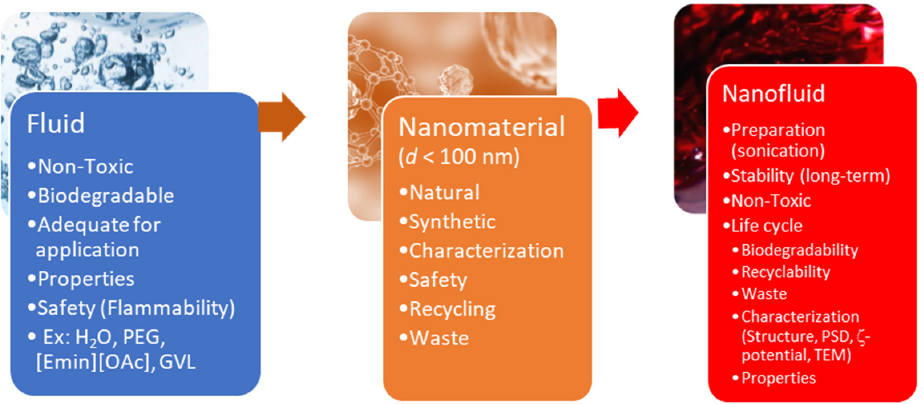
Figure 2. Elucidative diagram to orient researchers/users to decide about the best methodology to prepare a sustainable NF/INF, adhering to safety, health, and environmental